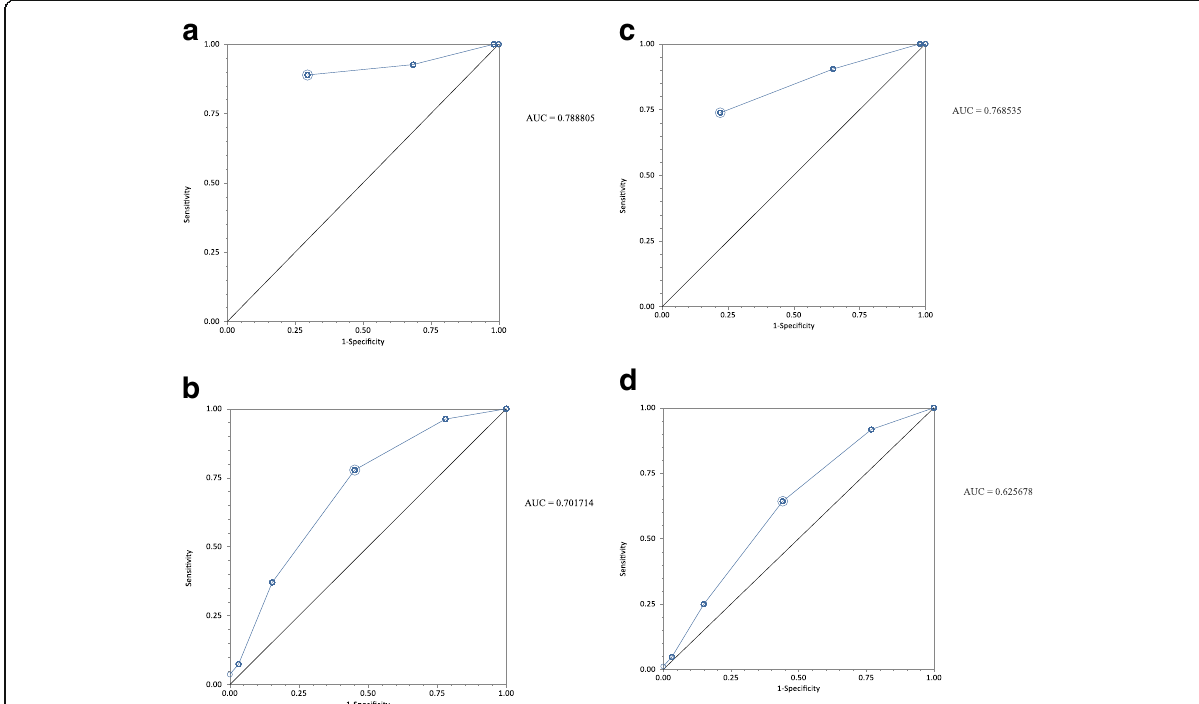
Fig. 2 a The ROC curve for provider gestalt to predict 24-h mortality. b The ROC curve for mSIRS criteria to predict 24-h mortality. c The ROC curve for provider gestalt to predict overall in-hospital mortality. d The ROC curve for mSIRS criteria to predict overall in-hospital